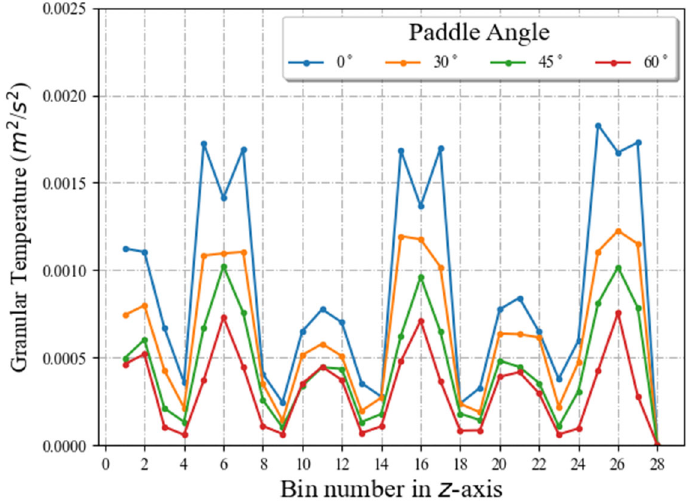
Figure 13. Granular temperature in a line along z direction for various paddle angle of 0°, 30°, 45° and 60°.